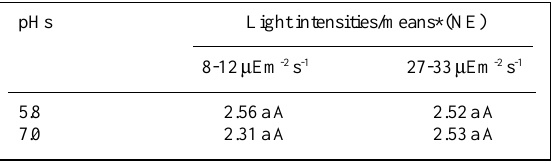
*Means followed by the same lower case letters in the column and by the same upper case letters in the line did not differ at 5% level of prob- ability by the Tukey